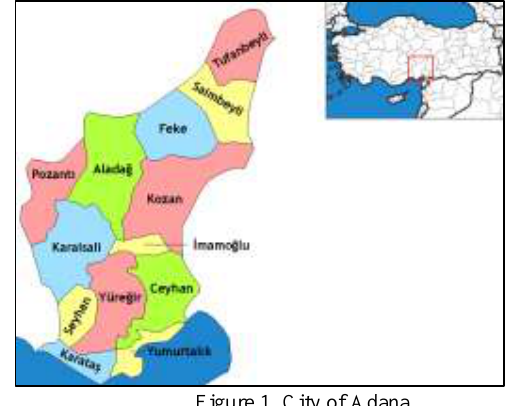
Figure 1. City of